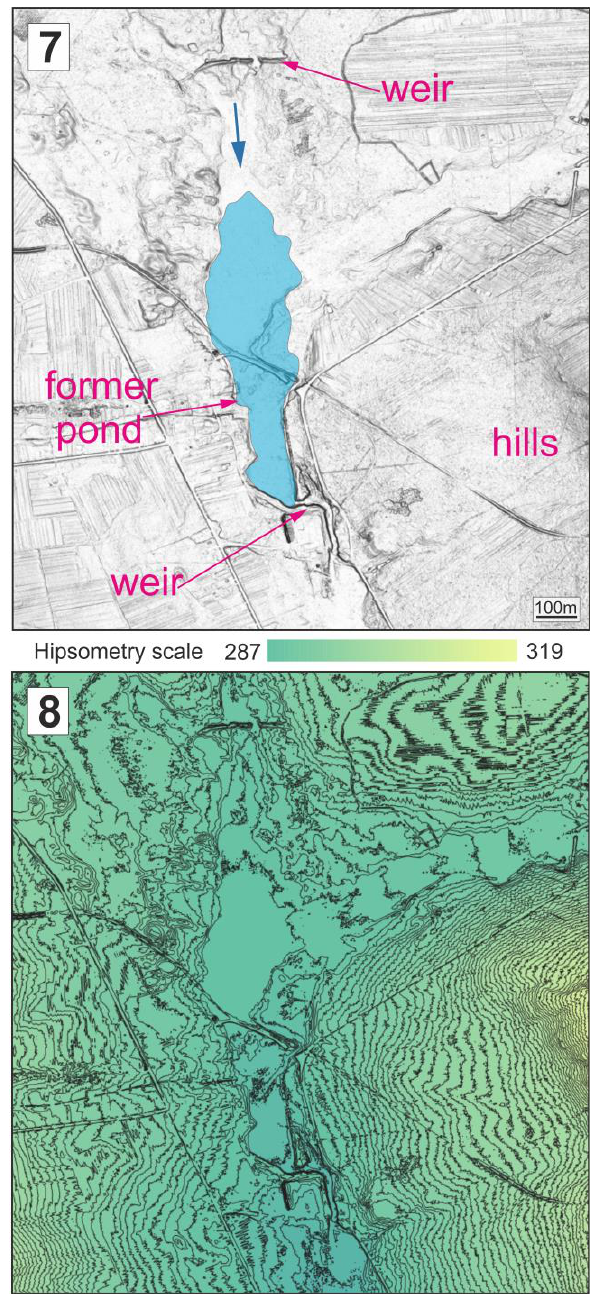
Fig. 8. Location of the former Furmanów ironworks: 7 – on the shaded relief map; 8 – on the coloured contour